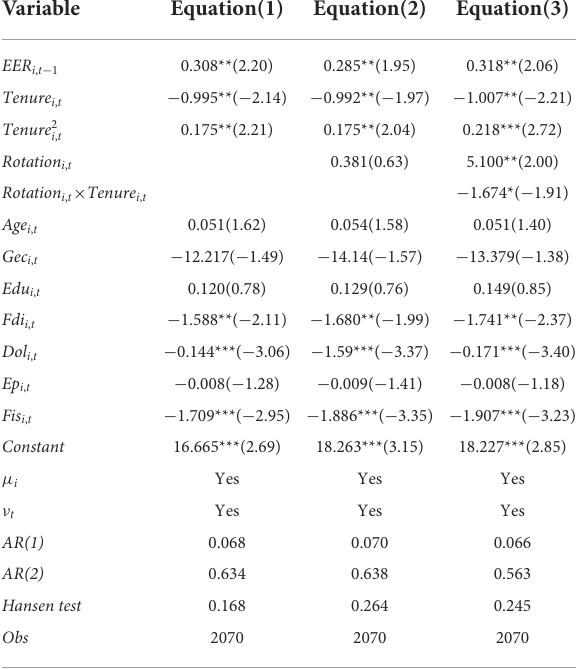
TABLE 2 Benchmark regression